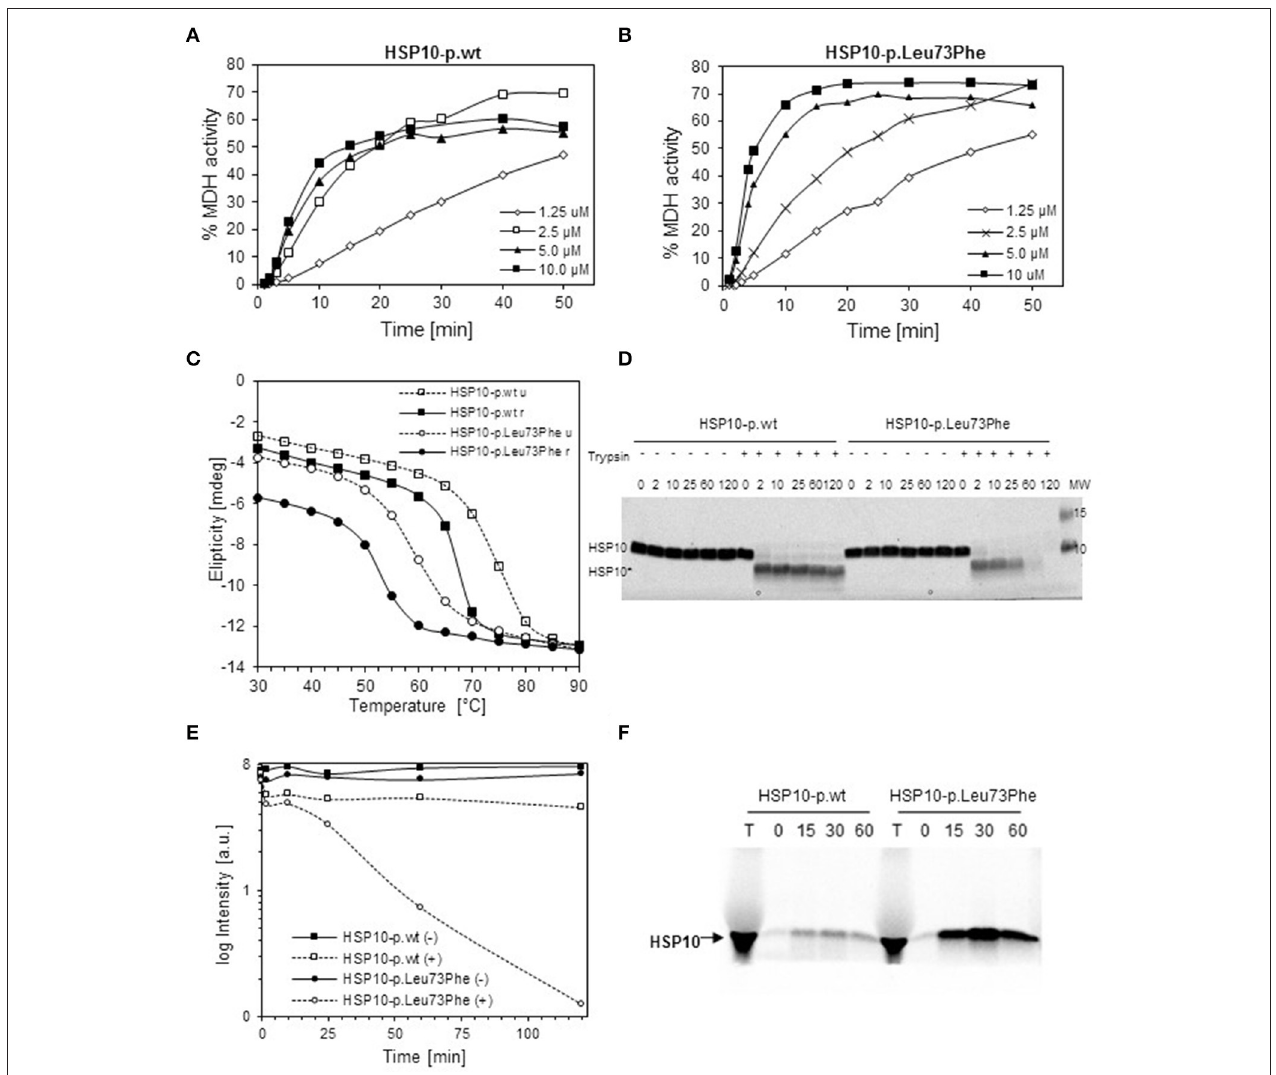
FIGURE 2 | In vitro properties of recombinantly produced HSP10-p.Leu73Phe. (A,B) Refolding kinetics of denatured MDH. HCl-denatured MDH (0.33 mM) was refolded at 30 ◦ C with HSP60 (10 µ M), ATP (1 mMol/L) and the indicated concentrations of wild type (A) or p.Leu73Phe mutant (B) HSP10. Refolding is expressed as the percentage of MDH activity before denaturation. (C) Thermal unfolding/refolding kinetics of wild type and p.Leu73Phe mutant HSP10. Folding status was monitored by following the circular dichroism signal at 222 nm. 0.3 mg/ml HSP10-p.wt or HSP10-p.Leu73Phe in buffer containing 50 mM Tris-HCl pH 7.7 and 100 mM NaCl were analyzed. The experiments were carried out by varying the temperature from 25 to 90 ◦ C (stippled lines; u = unfolding) and back to 25 ◦ C (solid lines; r = refolding). Ellipticity was measured with 2 ◦ C intervals, 180s setting time and 120s time per point. (D) Limited proteolysis of HSP10 proteins with trypsin. HSP10-p.wt and HSP10-Leu73Phe at 0.1 µ g/ml in 100 mM Tris-HCl (pH 7.8) were incubated at 37 ◦ C with or without addition of trypsin at a stoichiometric ratio of 1:10 (trypsin: HSP10). Proteolysis was stopped with addition of SDS PAGE sample buffer at the time points indicated and proteins were separated by SDS PAGE and stained with Coomassie. The positions of full-length HSP10 and HSP10 core fragment are indicated. (E) Quantification of the band-intensities from the Coomassie-stained gel shown in (D) . (F) Import kinetics of wild type and p.Leu73Phe mutant HSP10 into isolated mouse liver mitochondria. The HSP10 proteins were synthesized and radioactively labeled using a reticulocyte lysate system programmed by plasmids carrying the respective cDNAs as described in Materials and Methods. Translated proteins were added to freshly isolated mouse liver mitochondria and incubated at 37 ◦ C. Aliquots were taken at the time points indicated,